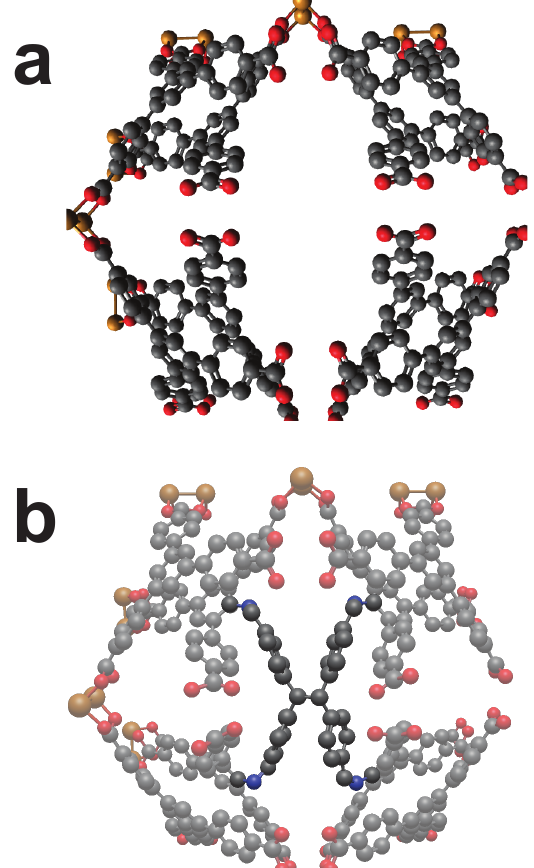
Figure 8. The MOF “QOWRAV12” can be cross-linked using cross-linker with four binding points. ( a ): Unmodified view of QOWRAV12. ( b ): Cross-linked QOWRAV12. Color code: as above plus Copper (Gold). Hydrogens omitted for